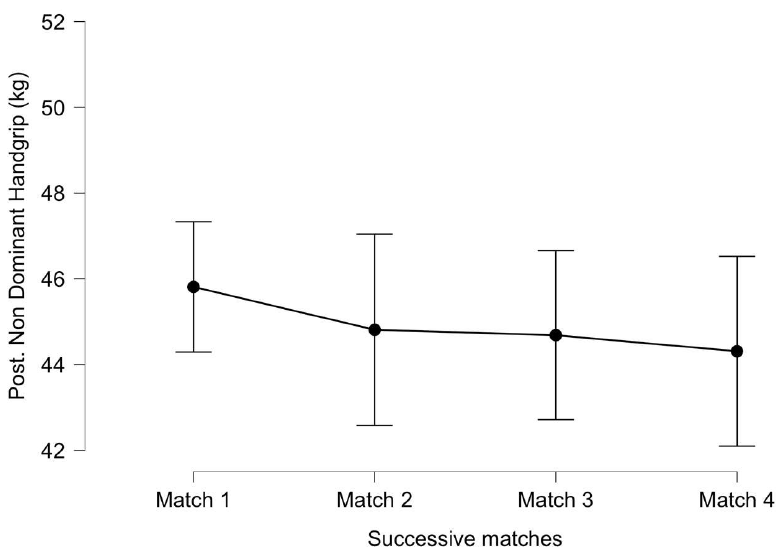
Figure 6. Post-match non-dominant handgrip strength throughout successive matches. Lines denote the mean (95 CI).